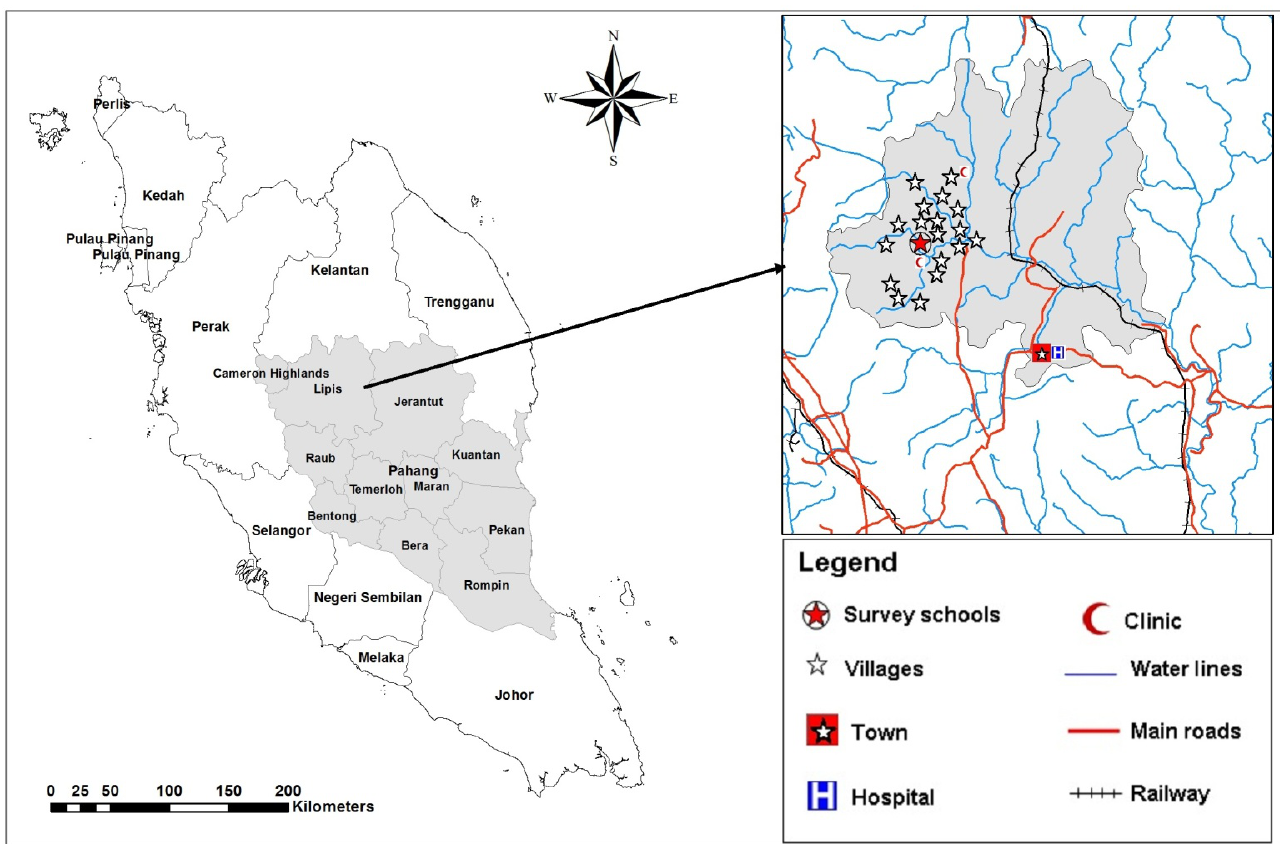
Figure 1. A geographic map showing the study area (location of school and villages in Lipis